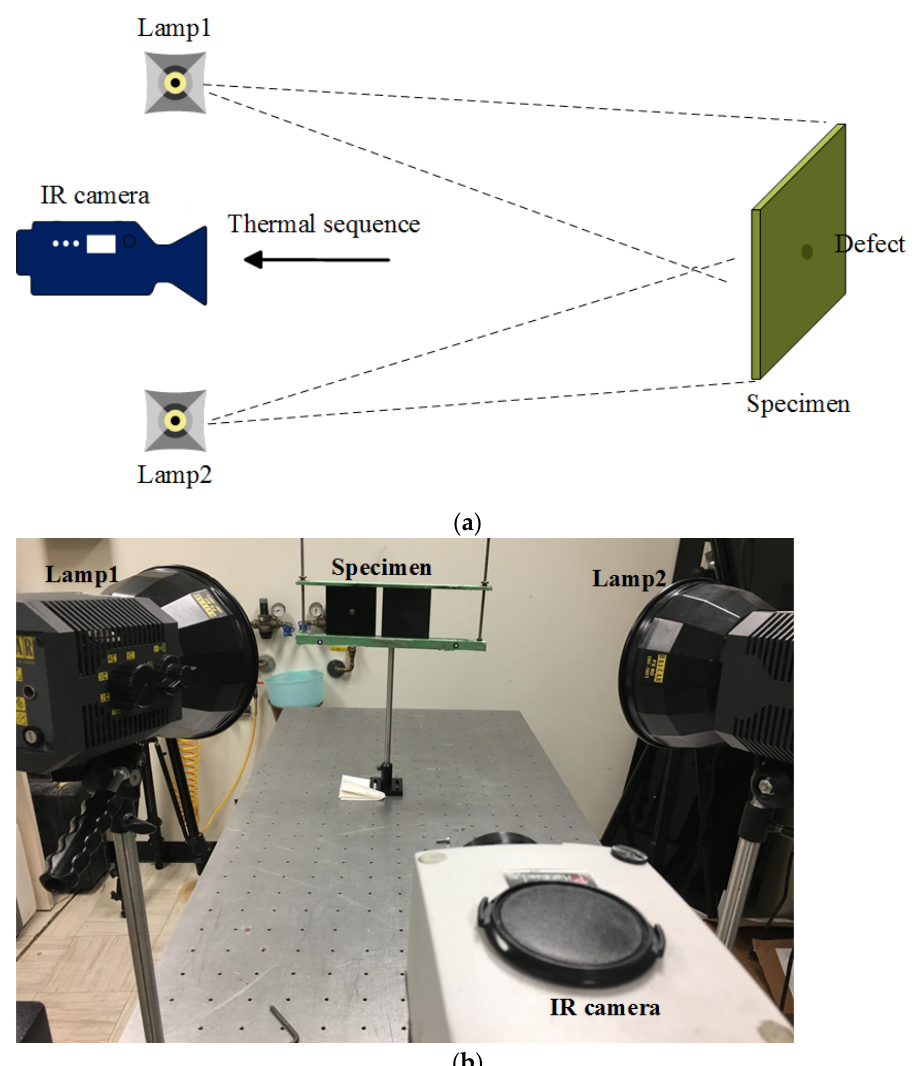
Figure 3. Optical excitation thermography inspection: ( a ) schematic configuration; ( b ) experimental set ‐ up.